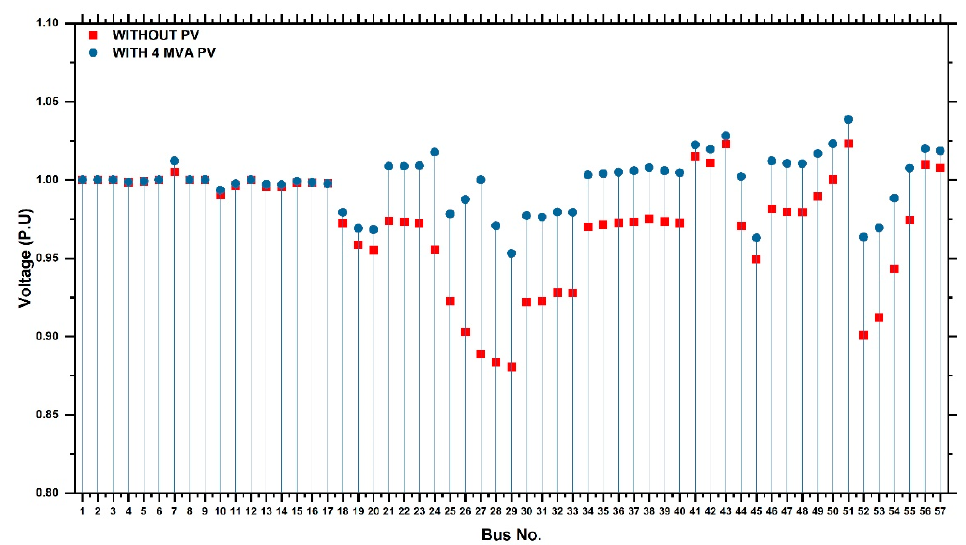
Figure 14. 4 MVA—voltage profile with and without a photovoltaic generator.